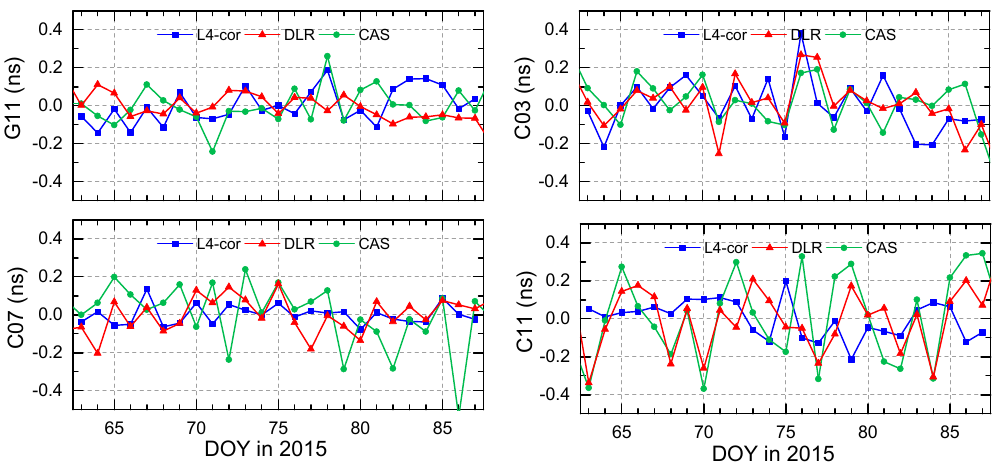
Figure 6. The DCB day-to-day variation series of G11 (GPS), C03 (BDS GEOs), C07 (BDS IGSOs) and C11 (BDS MEOs) during March 2015 from L4-cor, DLR and CAS solutions.